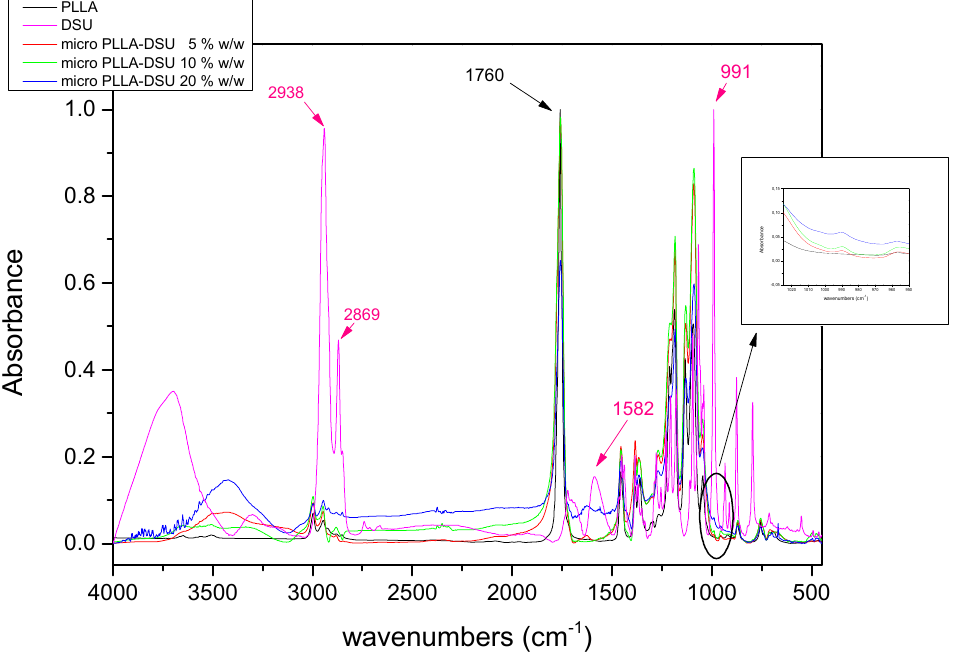
Figure 3. FT-IR spectra of PLLA, DSU and PLLA-DSU microparticles.